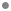
Role of K+-channels within the relaxant effect of levosimendan in human PCLS.A) Inhibition of KATP-channels (glibenclamide) in ET-1 pre-constricted PAs: ○ 100 nM ET-1 / 10 μM glibenclamide (n = 6); ● 100 nM ET-1 / 10 μM glibenclamide / levosimendan (n = 6); ● 100 nM ET-1 / levosimendan (n = 6). B) Inhibition of KV-channels (5-aminopyridine) in ET-1 pre-constricted PAs: ○ 100 nM ET-1 / 5 mM 5-aminopyridine (n = 6); ● 100 nM ET-1 / 5 mM 5-aminopyridine / levosimendan (n = 6); ● 100 nM ET-1 / levosimendan (n = 6). C) Inhibition of BKCa2+-channels (iberiotoxin) in ET-1 pre-constricted PAs: ○ 100 nM ET-1 / 100 nM iberiotoxin (n = 5); ● 100 nM ET-1 / 100 nM iberiotoxin / levosimendan (n = 5s); ● 100 nM ET-1 / levosimendan (n = 5). D) Effect of inhibition of K+-channels on the contractile effect of ET-1. A-C: Statistics was performed by the comparison of EC50 values. D: Statistic was performed by an one-way ANOVA. P<0.05 are considered as significant: * p<0.05, ** p<0.01 and *** p<0.001.